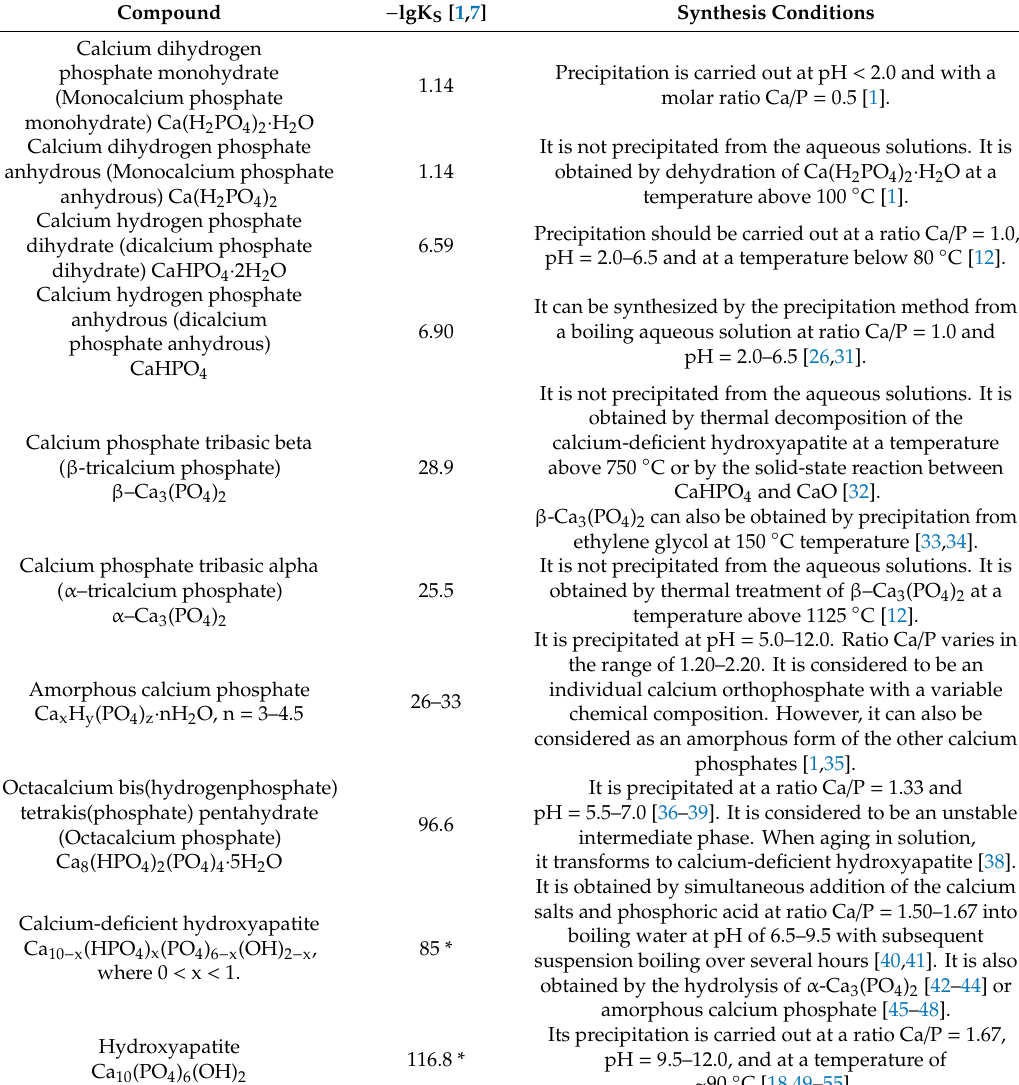
Table 1. The calcium orthophosphates, their solubility products (K S ) at 25 ◦ C, and the synthesis